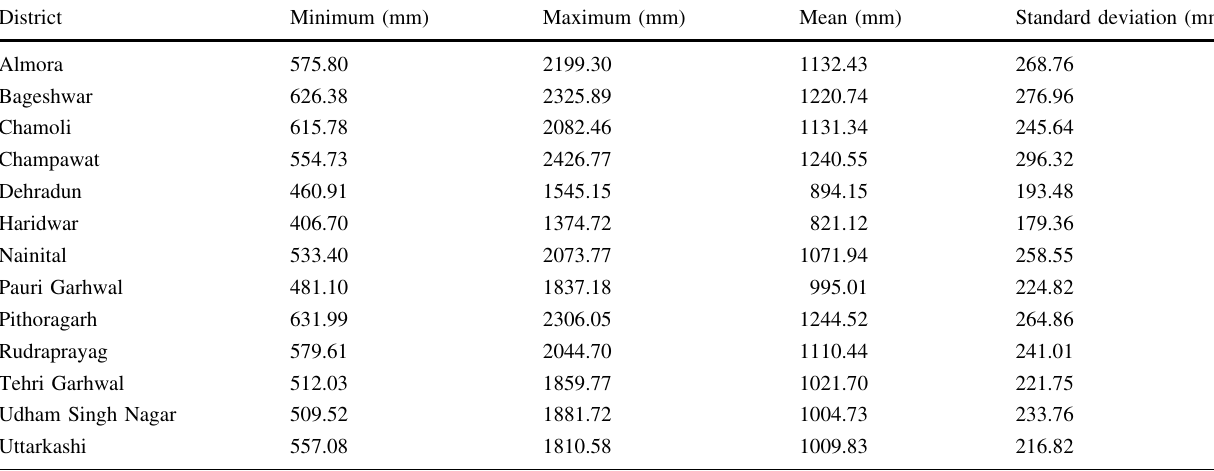
Table 2 Summary of statistics for annual rainfall (1901–2002)